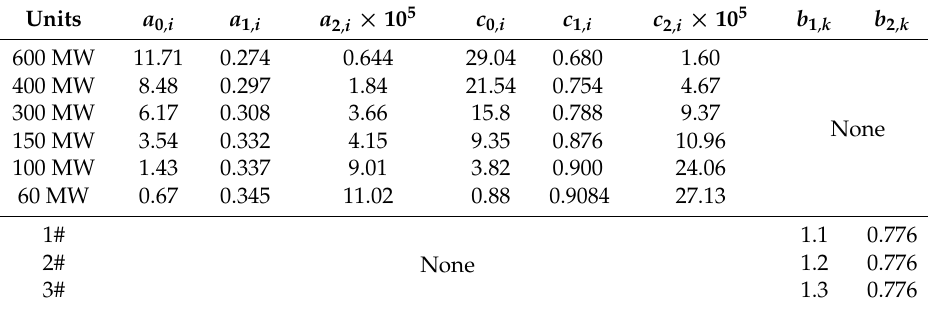
Table 3. Parameters of thermal power and biomass power units.